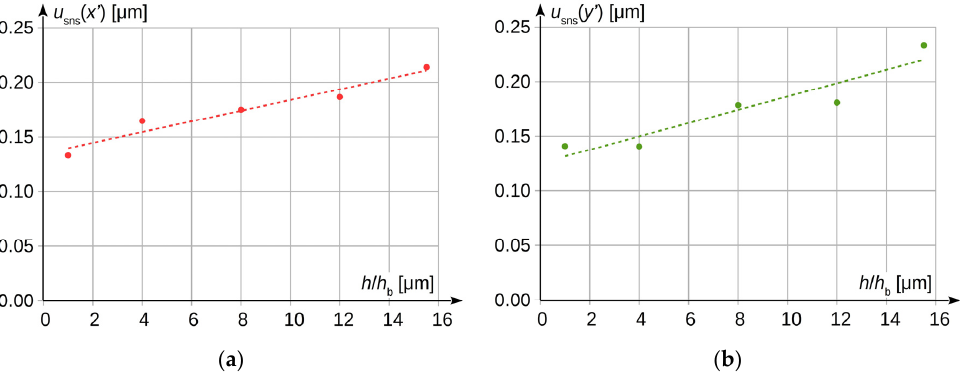
Figure 6. Dependence between uncertainty u sns of measurement results from actual sensor sensitivity: ( a ) in horizontal axis u sns ( x’ ); ( b ) in vertical axis u sns ( y’ ).